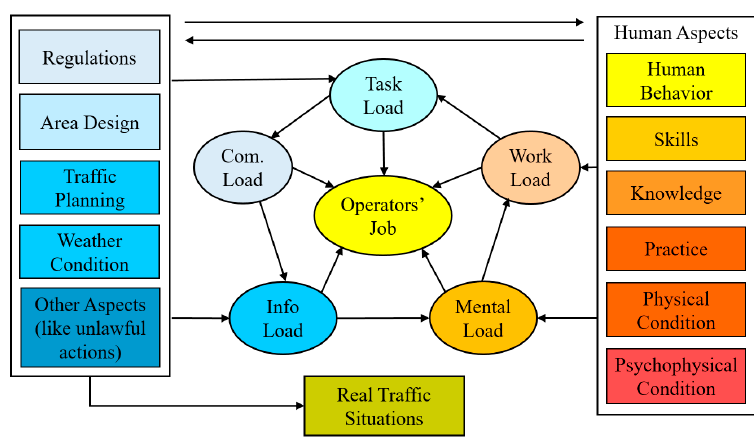
Figure 4. The improved “Operator Load Model” published by Endsley [41].